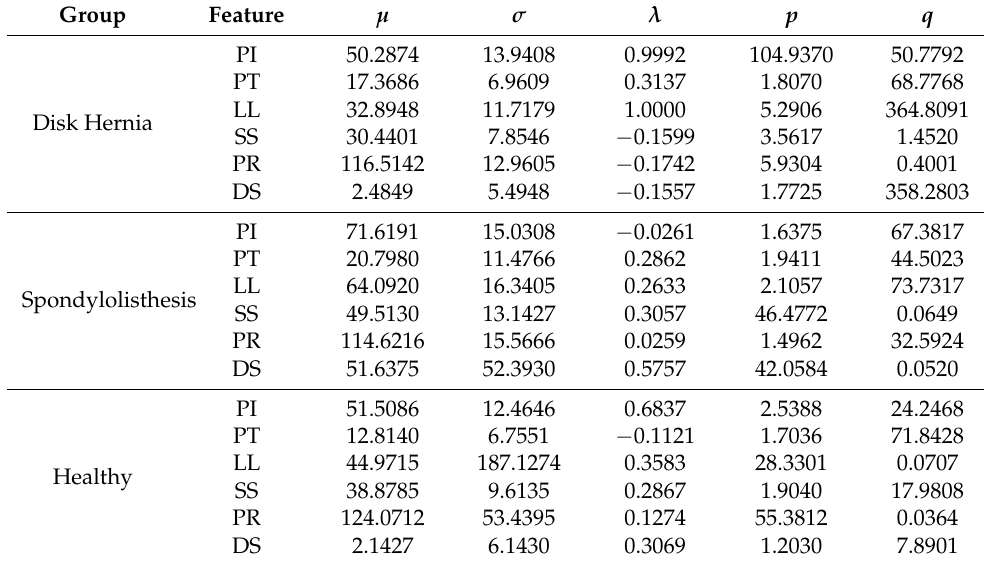
Table 2. Fitted parameters for each margin